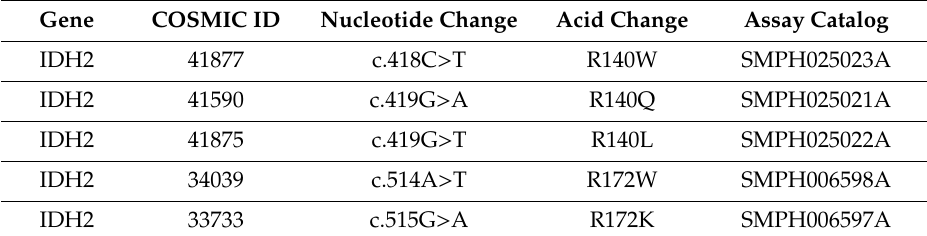
Table 6. IDH2 point mutations in qBiomarker Somatic Mutation PCR Arrays.